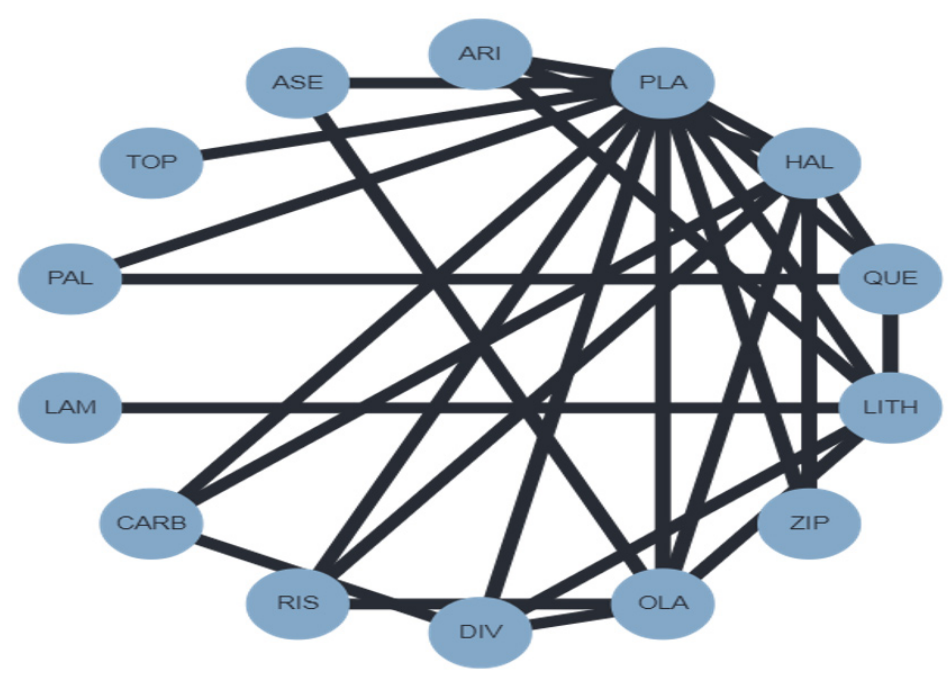
Figure 4. Network plot for the network of antimanic drugs. ASE, asenapine; ARI, aripiprazole; PLA, placebo; HAL, haloperidol; QUE, quetiapine; LITH, lithium; ZIP, ziprasidone; OLA, olanzapine; DIV, divalproex; RIS, risperidone; CARB, carbamazepine; LAM, lamotrigine; PAL, paliperidone; TOP, topiramate; ASE, asenapine.